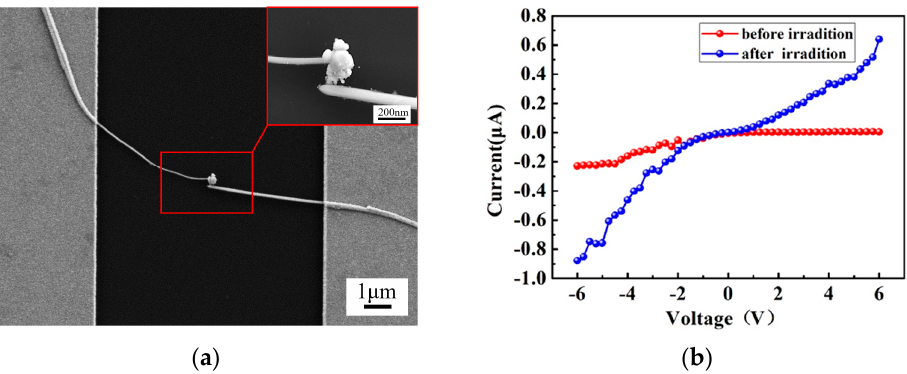
Figure 5. Electrical characterizations of ZnO nanowires and Ag nano-solder interconnection. ( a ) Test electrode of nanowire interconnection structure; ( b ) I − V electrical test curve before and after solder- ing.